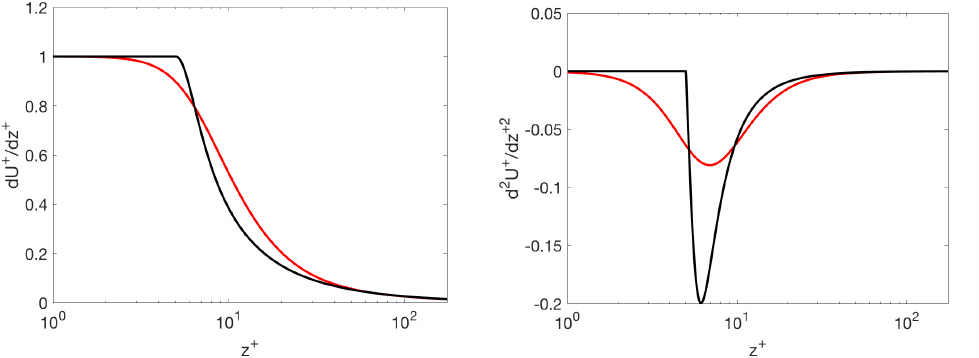
Figure 3. Colour online. Normalised derivatives of the van Driest velocity profile (in red) and the lin-log profile (in black), against the normalised z coordinate. Left : first derivative and right : the second derivative. Note the sharp discontinuity of the second derivative for the lin-log